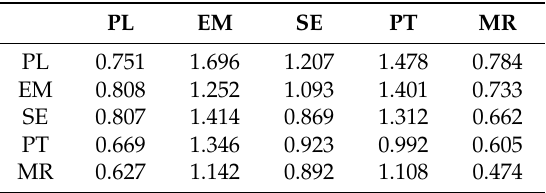
Table 6. Total-relation matrix T.